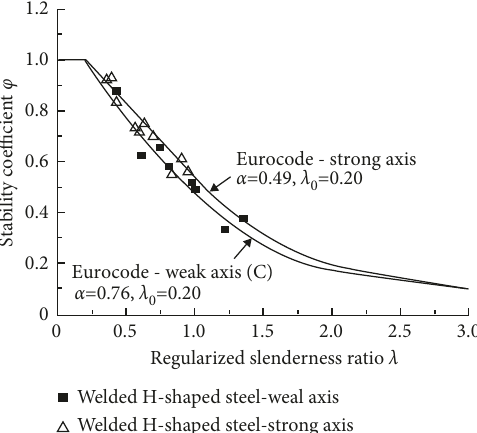
Figure 2: Strength curves in Eurocode and proposed strength curve for C.